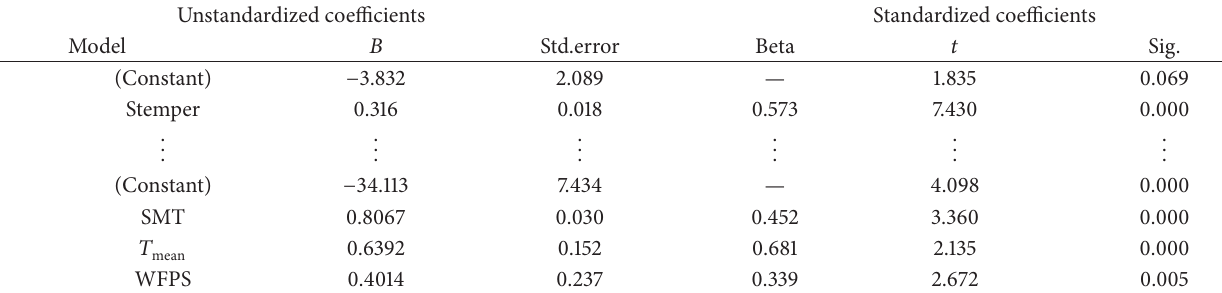
Table 6: Path coefficient of each factor on CO